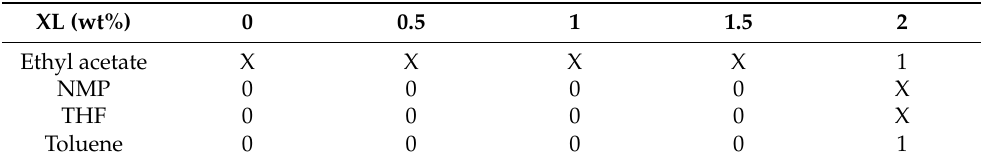
Figure 2. The effect of cross-linker on the performance of UV-cured PSf membranes consisting of 10 wt% PSf and 0.3 wt% PhIn. Table 3. Qualitative observation of the solvent stability of UV-cured PSf supports prepared with different cross-linker concentrations.